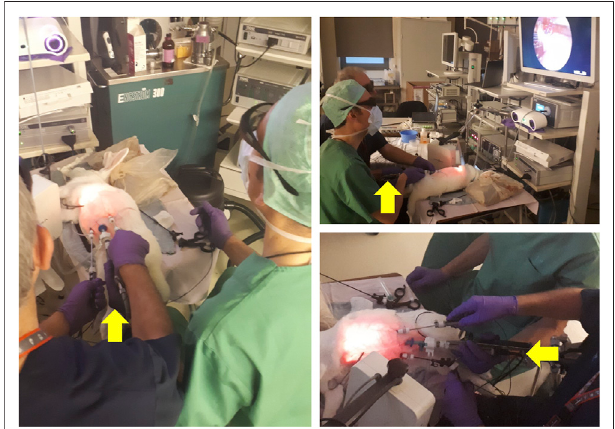
FIGURE 12 | Spina bi fi da intervention performed on an animal model. Thesurgeondressedinbluescrubscontrolstheinstrumentsandmanipulates the tissue. The colleague dressed in green guides and holds the endoscope camera during the intervention. The yellow arrows point to the hand of the assistant guiding the camera. As becomes evident in the pictures above, this operating arrangement is not ergonomic, leading to discomfort that increases with the duration of the intervention, and severely limiting the tasks that the surgeon controlling the camera can perform. Picture courtesy of Prof. Jan